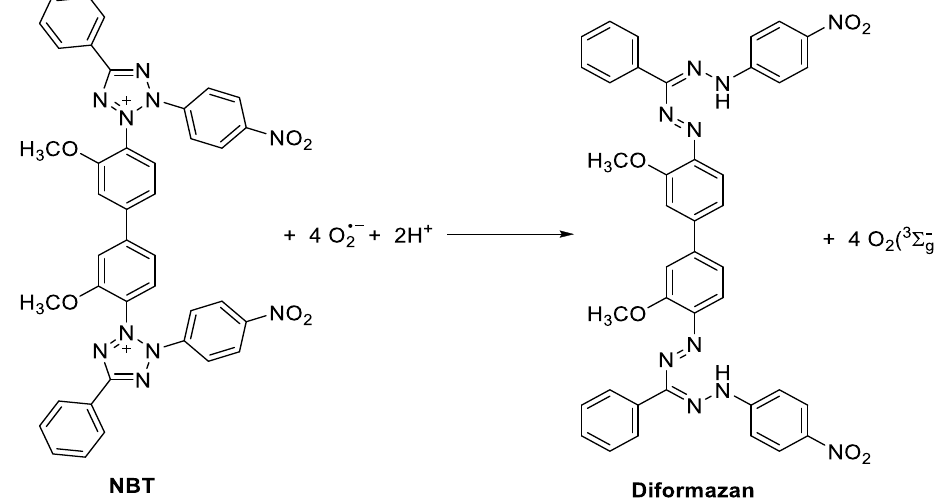
Figure 4. First-order plots for the photooxidation of DMA sensitized by PTPPF 16 -EDA (  ), PZnTPPF 16 -EDA (  ) and ZnTMP ( ⚫ ) in DMF,  irr = 424 nm (0.34 mW/cm 2 ).